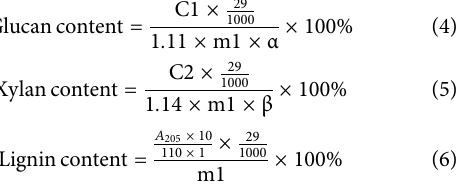
C2: Xylose concentration, β : Correction coef fi cient of xylose, m1: substrate weight.